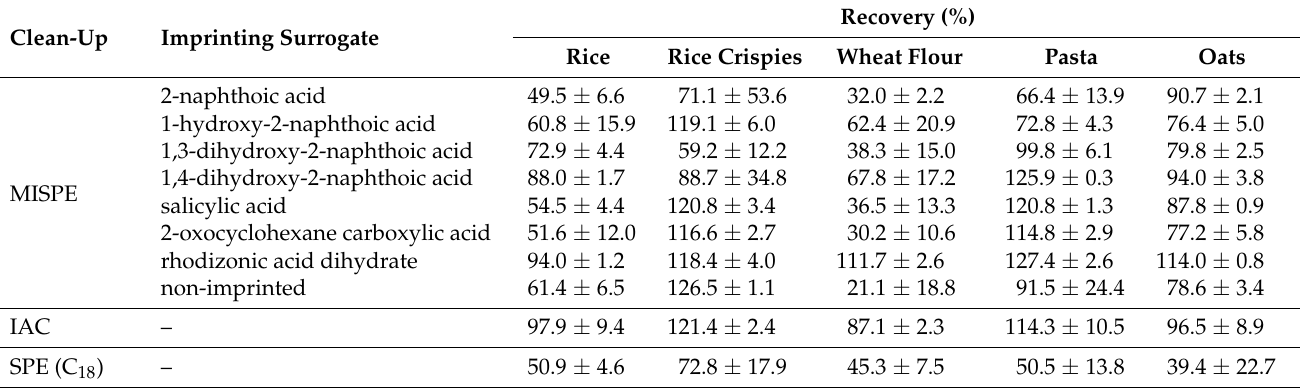
Table A1. CIT (400 ng/mL, 2 mg/kg) recoveries achieved by clean-up of rice, rice crispies, wheat flour, pasta, and oats applying MISPE, IAC, and SPE. Polymers for MISPE were imprinted using surrogates identified by pharmacophore modeling (mean ± RSD, n =